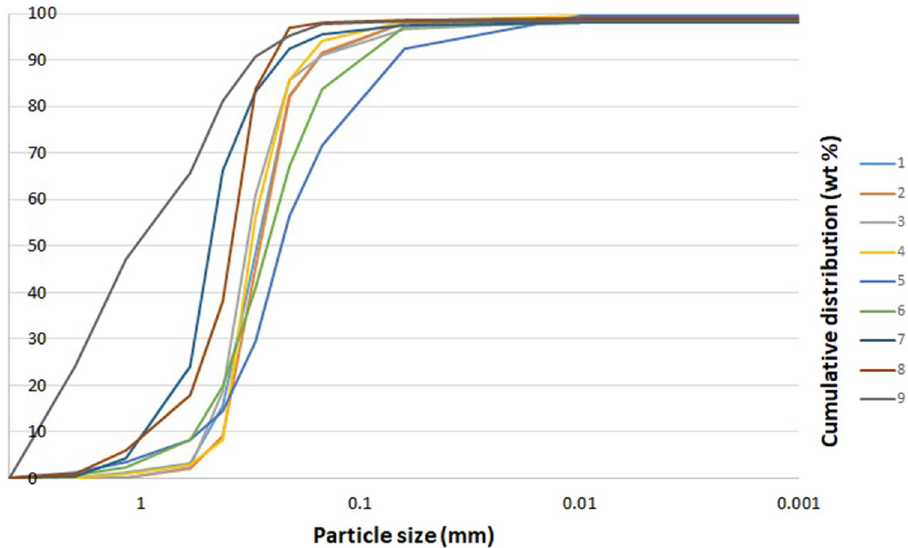
Fig. 2 PSD curves generated from grain size test of different Brunei outcrop samples (meas- ured at UTB by Ahad Aqilah)